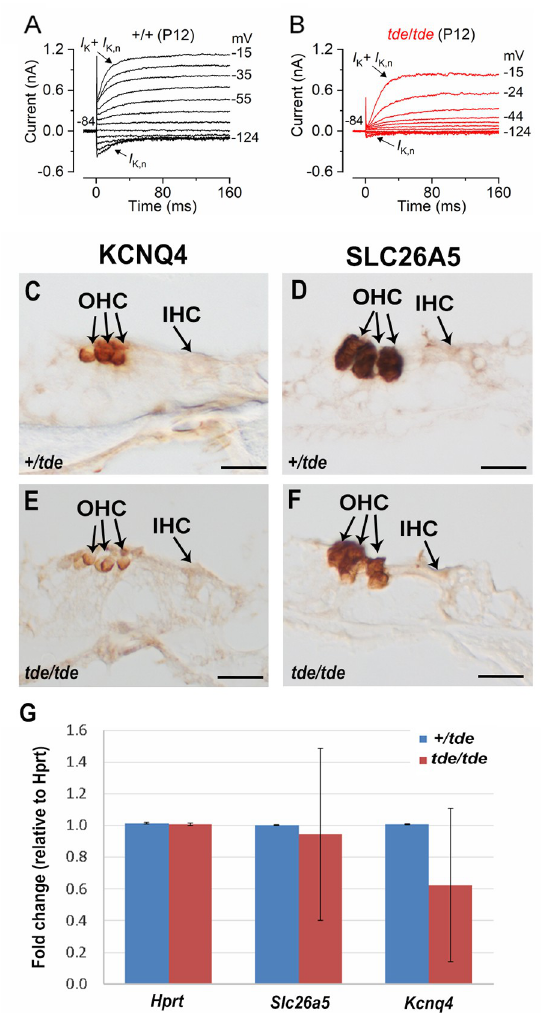
mV nominal increments from the holding potential of –84 mV. Control cells showed a large negatively activating K + current characteristic of adult OHCs, I K,n , whereas it was much smaller or almost absent in tde / tde OHCs. Recordings were made at room temperature. C-F , Expression of KCNQ4 and SLC26A5 observed using immunohistochemistry at P12 shows strong labelling in OHCs. G, Quantitative real-time PCR on cDNA generated from Hprt normalized total RNA from whole inner ear at P12 (n = 4 tde/tde ; n = 2 +/ tde ). Kcnq4 and Slc26a5 are both down-regulated in tde/tde mutant mice compared to controls but neither difference is statistically significant (P > 0.05, Wilcoxon rank sum test). Technical replicates (3 for each sample) showed minimal variation, but samples were more variable. Error bars represent standard